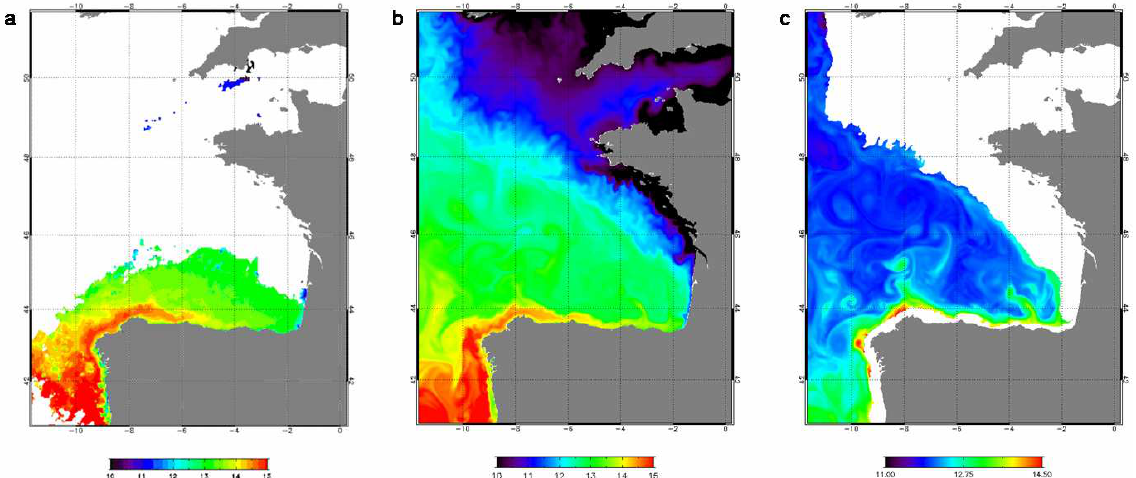
Fig. 17. Sea surface temperature ( ◦ C) from AVHRR data (a) and from the model (b) for 20 January 2008. Modelled temperature at 200m Figure 17: Sea surface temperature (°C) from AVHRR data (a) and from the model (b) the 20th of depth for 20 January 2008 (c) January 2008. Modelled temperature at 200 m depth the 20th of January 2008 (c).